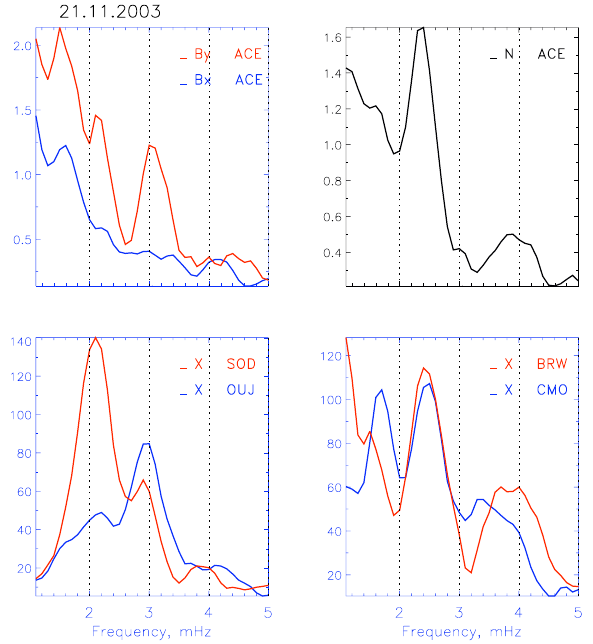
Fig. 9. The comparison of the Fourier spectra of ACE (upper pan- els) data for 05:45–06:45 UT: B x (blue) and B y (red) of IMF data and solar wind density (black), with the spectra of the ground data (bottom panels): X component of morning Pc5 pulsations at SOD (red) and OUJ (blue), and evening Pi3 pulsations at BRW (red) and CMO